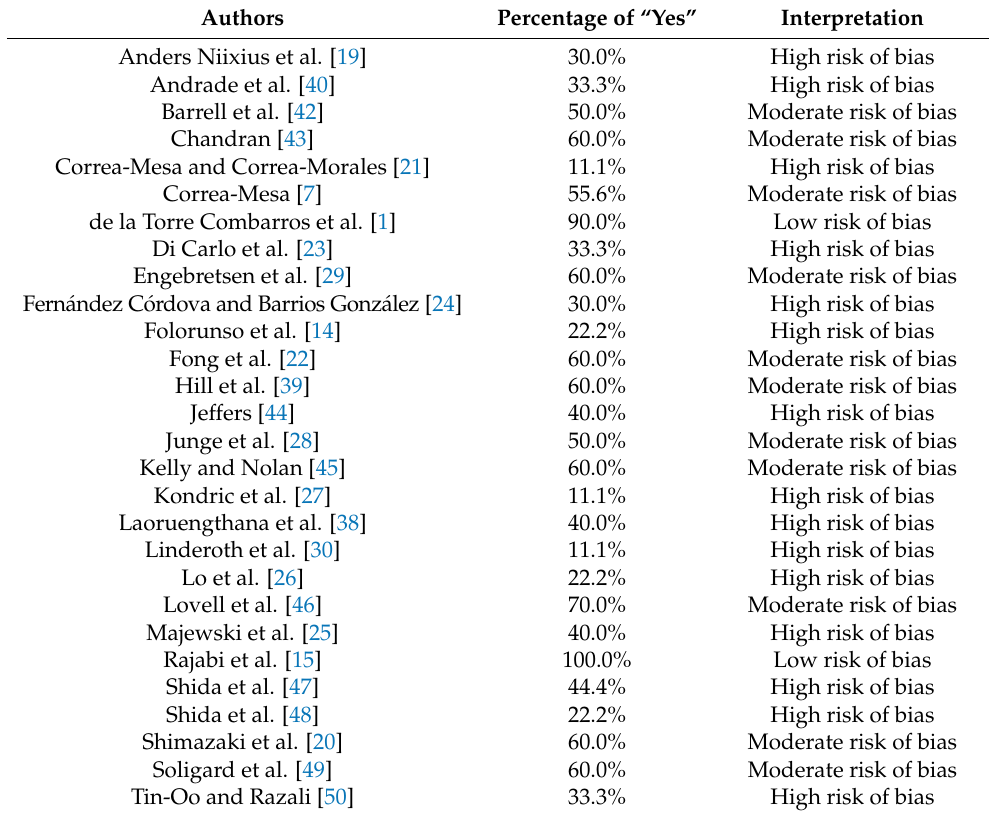
Table 4. Risk of bias assessment of the observational studies included in the present scoping review (excluded clinical cases reports/case